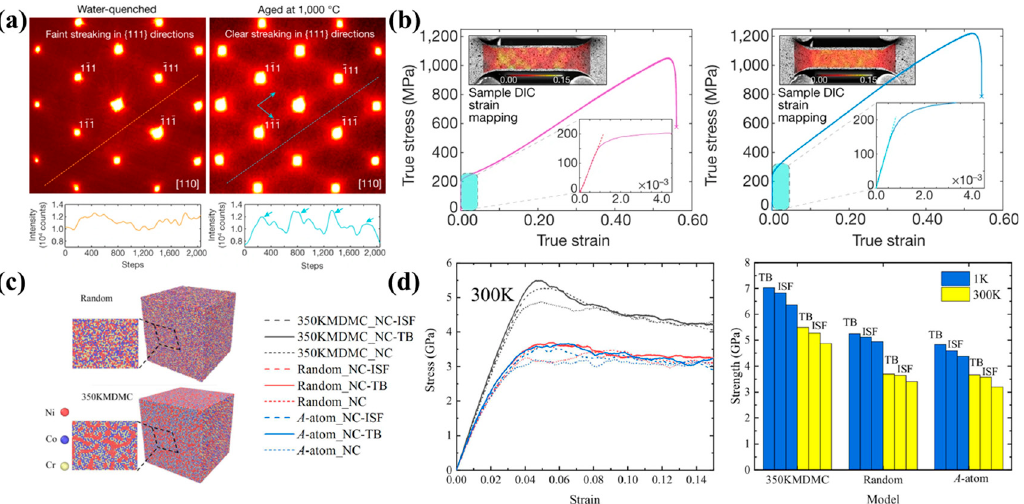
Figure 7. Effect of CSRO on the mechanical properties of MPEAs. ( a ) Main panels, energy-filtered diffraction patterns for water-quenched and aged samples, respectively. Plot below shows intensity measured along the diagonal line in the main panel (Reprinted with permission from Ref. [26]. Copyright 2020, Springer Nature). ( b ) Tensile stress–strain curves of a water-quenched sample (left) and an aged sample (right), respectively. Lower insets represent the elastic portions of the curves (Reprinted with permission from Ref. [26]. Copyright 2020, Springer Nature). The aged samples with strong CSRO shows a better performance. ( c ) Atomic configurations of MPEAs with and without CSRO (Reprinted with permission from Ref. [36]. Copyright 2020, Elsevier). ( d ) Stress–strain relation and the strength of CoCrNi alloys with the effect of CSRO (Reprinted with permission from Ref. [36]. Copyright 2020, Elsevier). The results show that the presence of CSRO greatly improves the strength and plasticity of CoCrNi MEA.